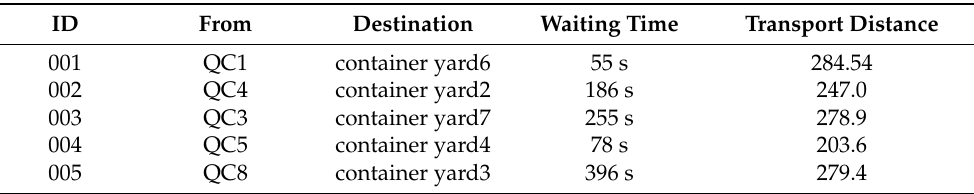
Table 3. Container task information.